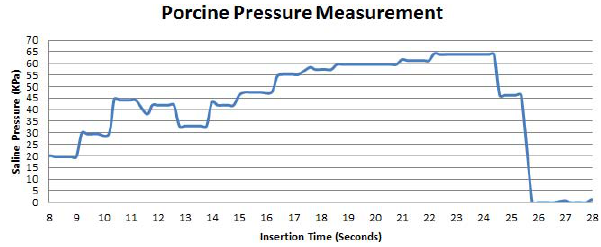
Figure 3. Line graph showing the KPa pressure measurement data.